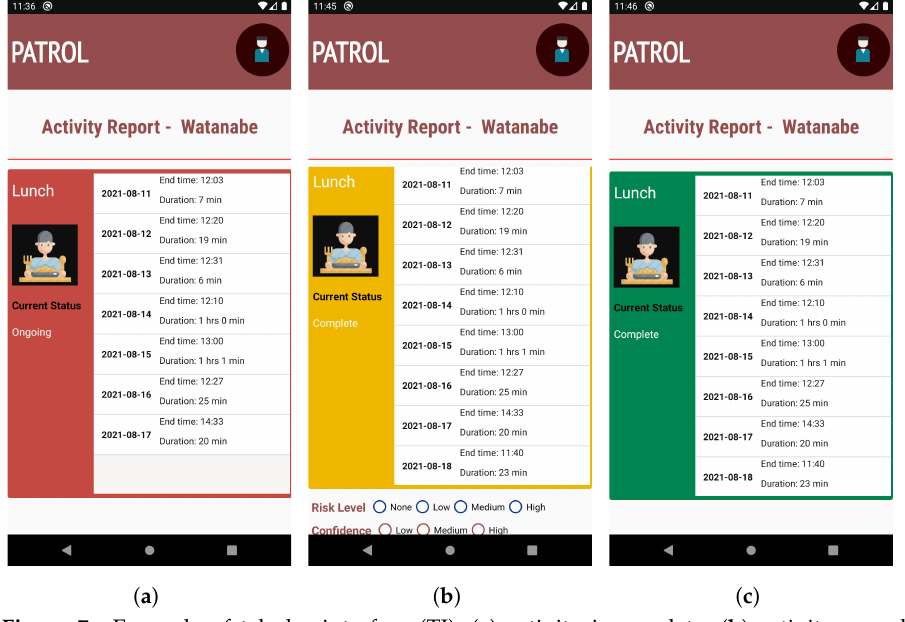
Figure 7. Example of tabular interface (TI): ( a ) activity incomplete, ( b ) activity complete and ( c ) activity